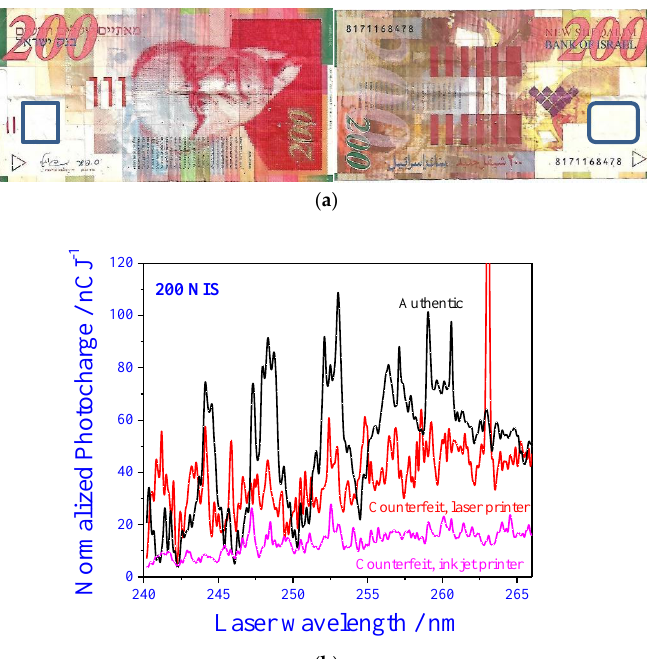
and inkjet-printed banknotes is presented in Figure 6b.